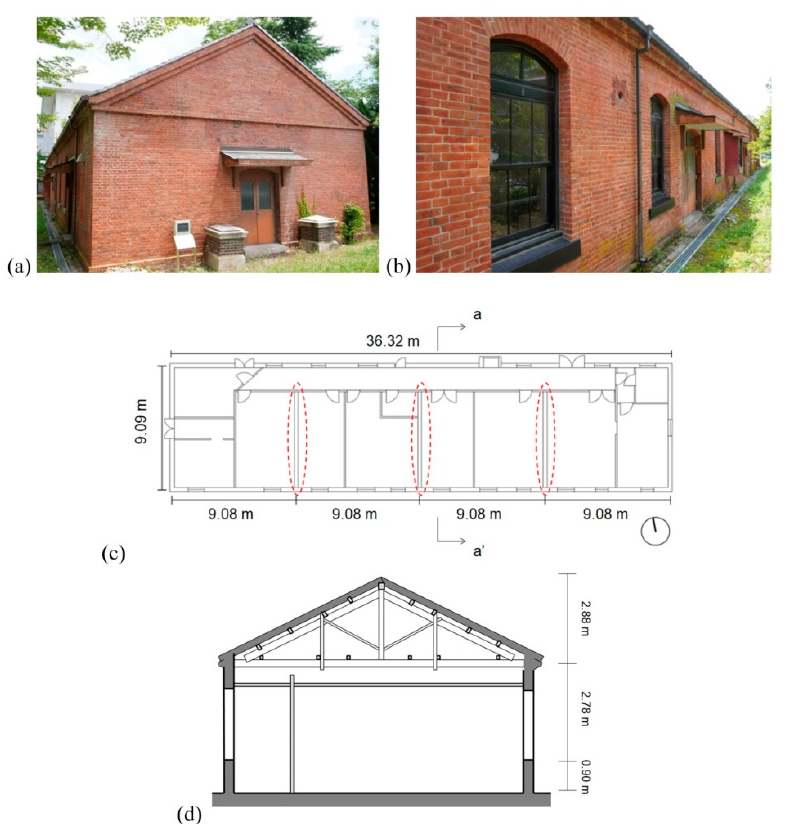
Figure 3. Matsumoto storehouse: ( a ) west elevation; ( b ) north elevation; ( c ) plan and ( d ) a–a’ sec- tion.